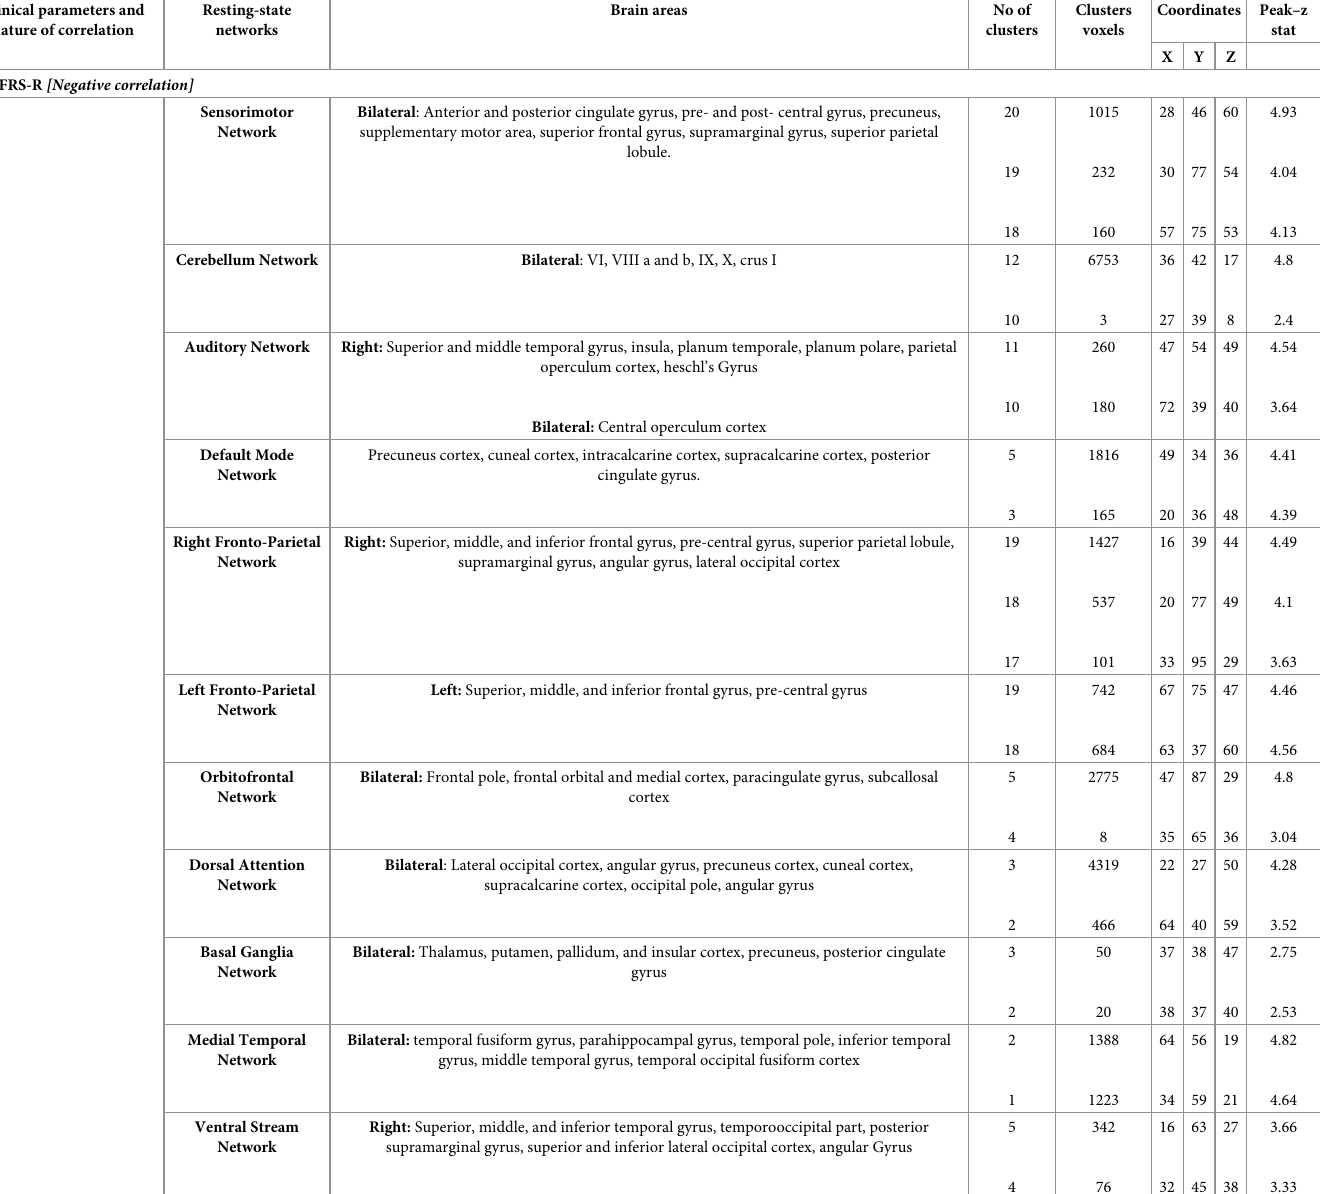
Brainareas Clusters